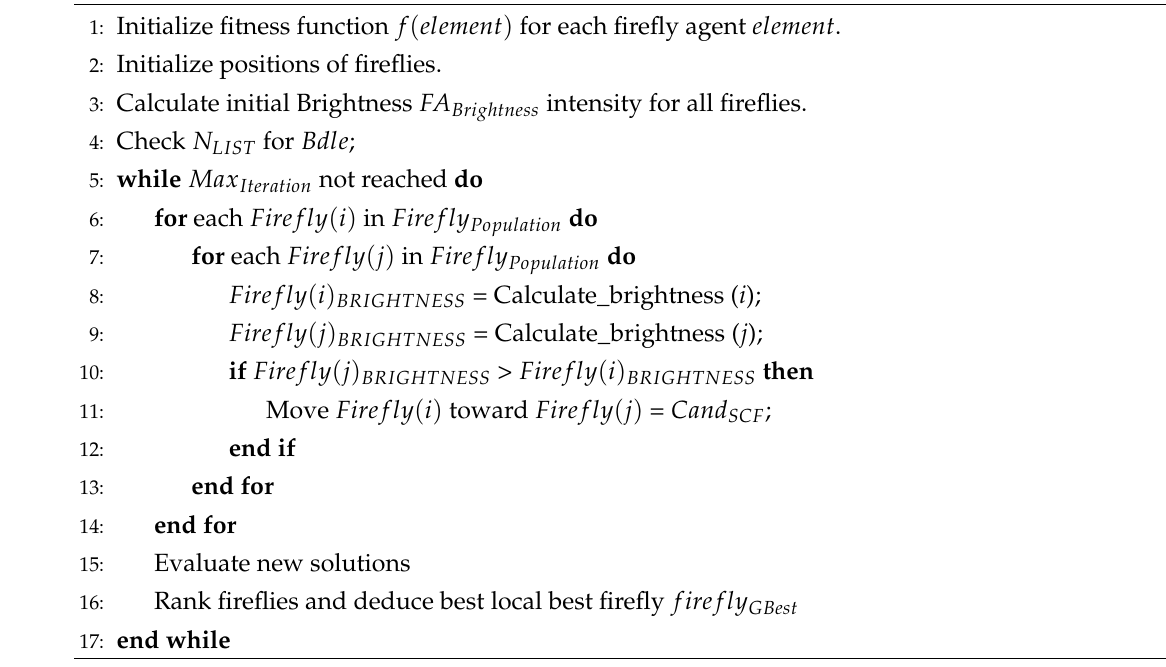
Algorithm 1 Pseudo-code of FA